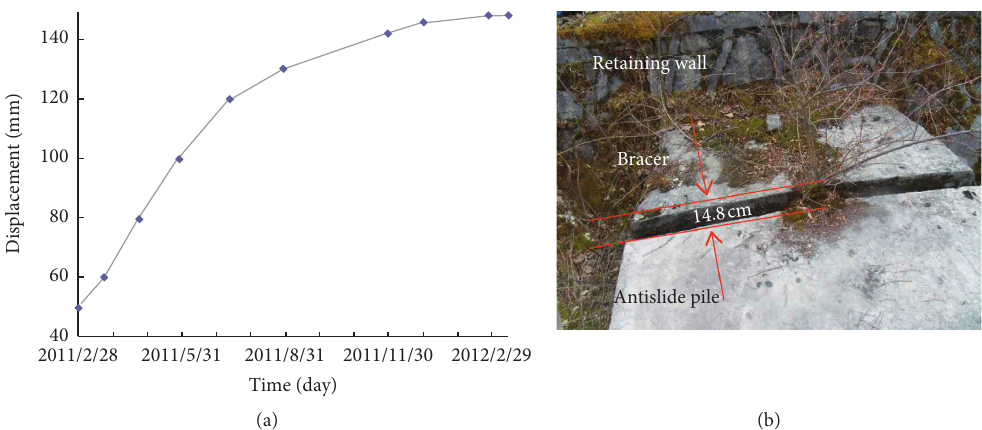
Figure 5: Site investigation of antislide pile deformations. (a) The maximum displacement of the pile head by Lycra automatic total station. (b) Displacement of the antislide pile head in the site investigation.